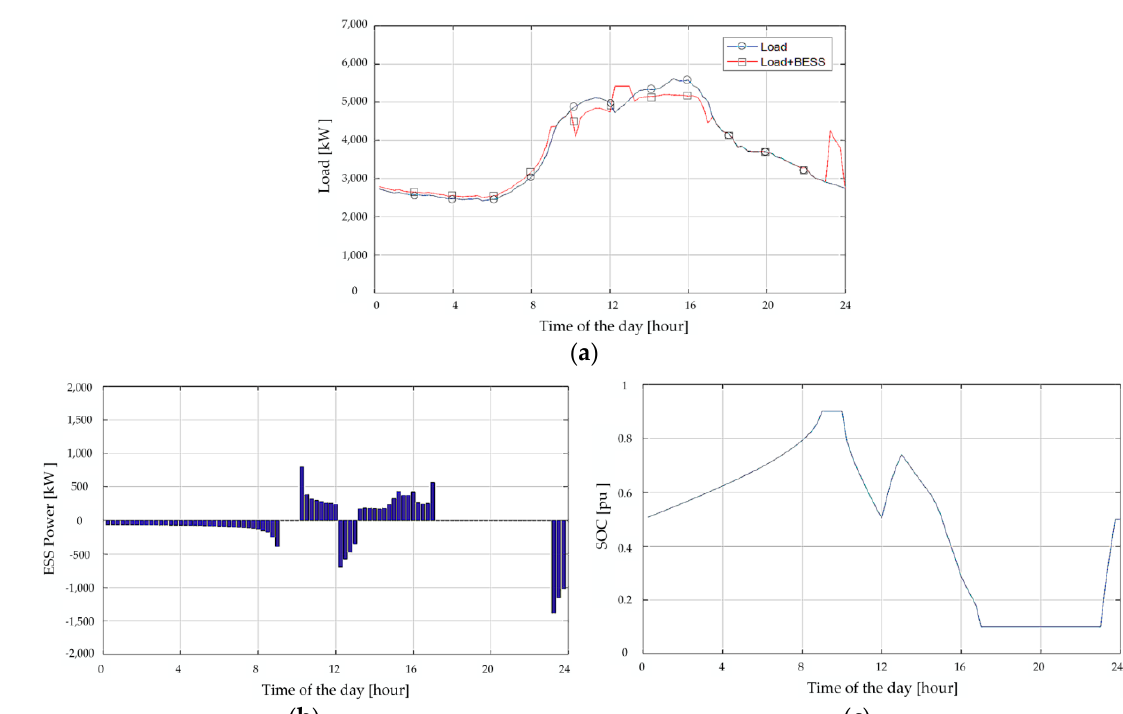
Figure 10. Case 2 simulation results. ( a ) Comparison of the original load and the load after ESS